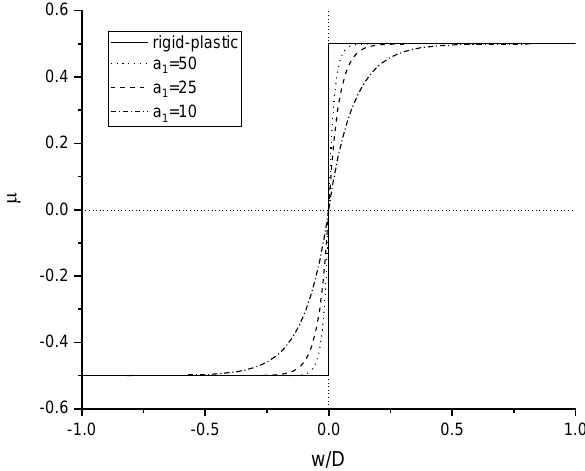
Figure 6. Pipe – soil interaction model with different 𝑎 1 . Figure 6. Pipe–soil interaction model with different a